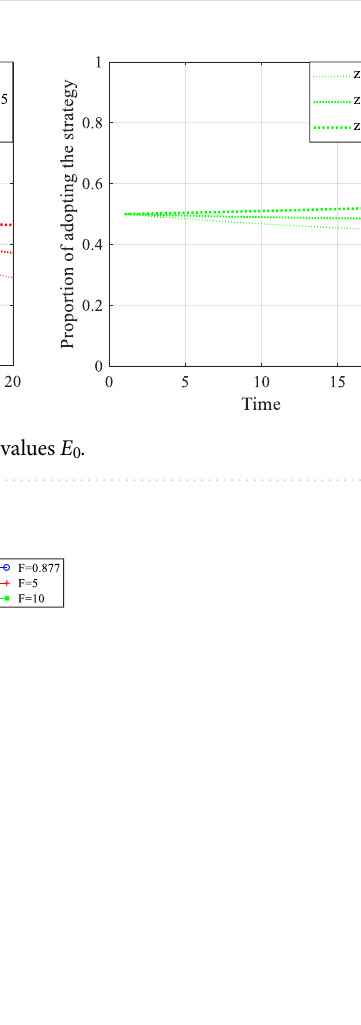
Figure 15. Behavior evolution of three players under different government punishments F